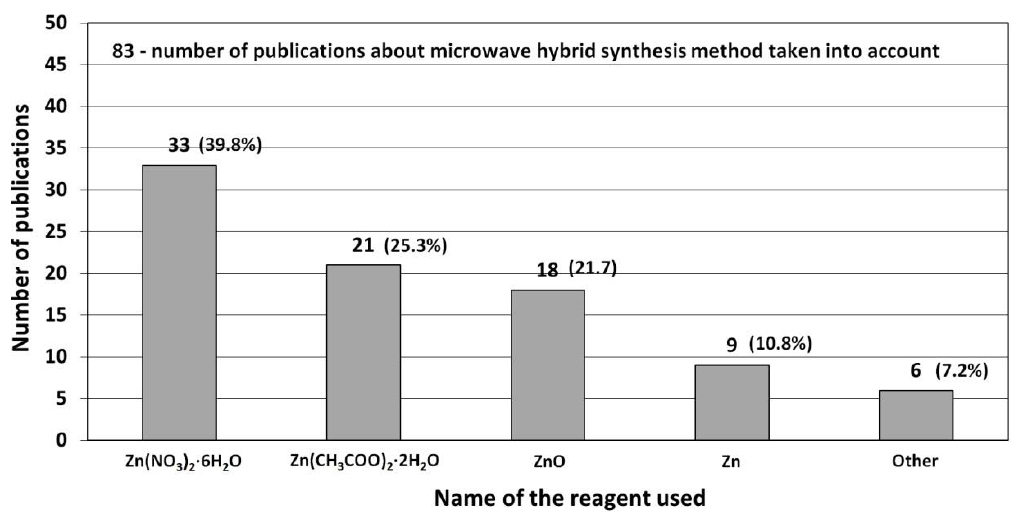
Figure 62. Statistics of use of reactants in the microwave hybrid synthesis method of ZnO. Source: